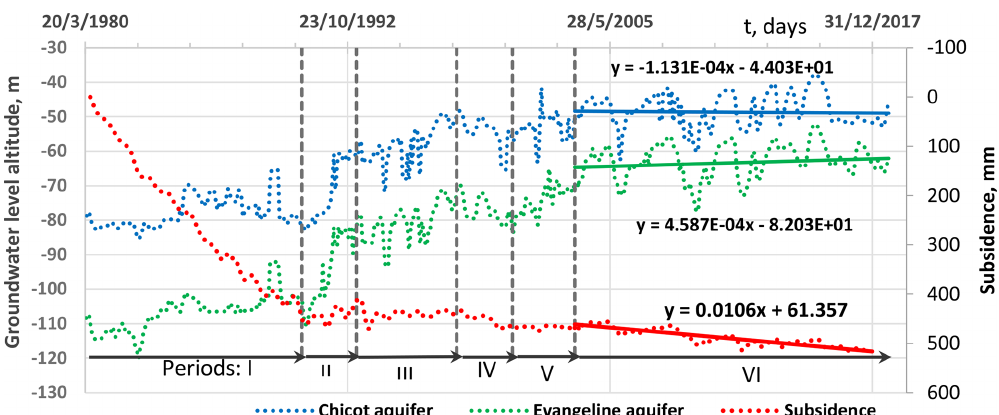
Figure 1. Groundwater levels in Chicot and Evangeline aquifers and land subsidence at extensometer site Southwest in the Houston- Galveston region. (Modified from Liu et al.,